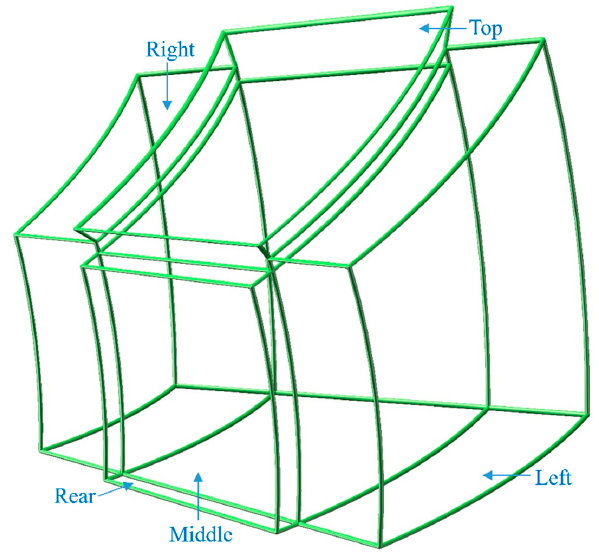
Materials 2020 , 13 , x FOR PEER REVIEW Figure 11. The distortion tendencies of five areas. Figure 11. The distortion tendencies of five areas.